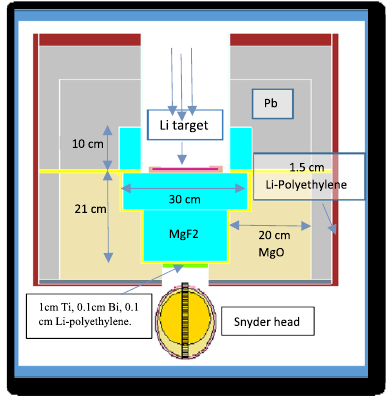
Fig. 9. Thefinal designed BSA. Fig. 9. The design of the BSA used in Ref. [23]